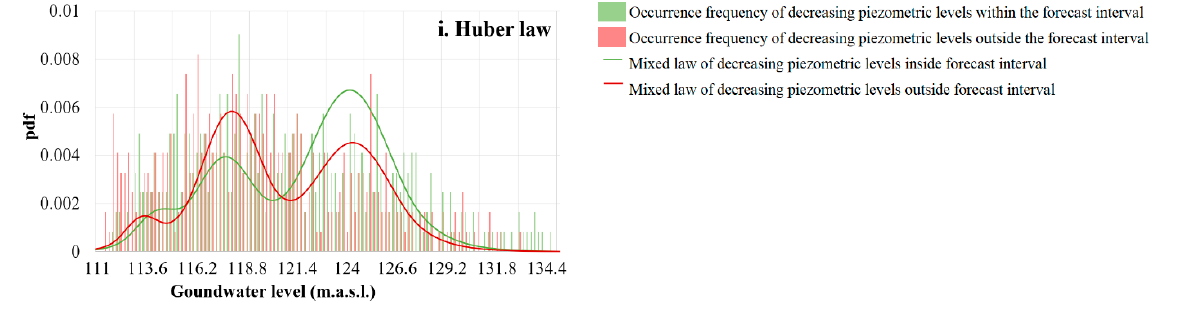
Figure 8. Composite pdf for decreasing measured groundwater distributions with ( a ) Normal law, ( b ) Gumbel law, ( c ) Laplace law, ( d ) Raised Cosine law, ( e ) Cauchy law, ( f ) Logistic law, ( g ) Slash law, ( h ) Bhattacharjee law and ( i ) Huber law.